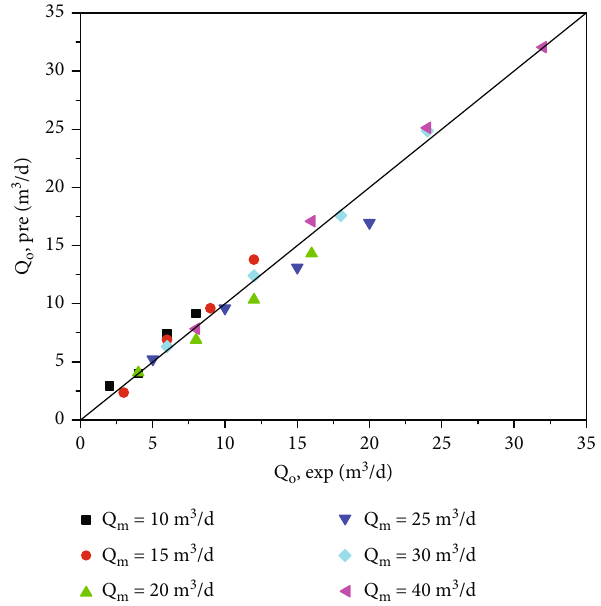
Figure 7: Forecast results of oil fl ow in oil-water two-phase fl